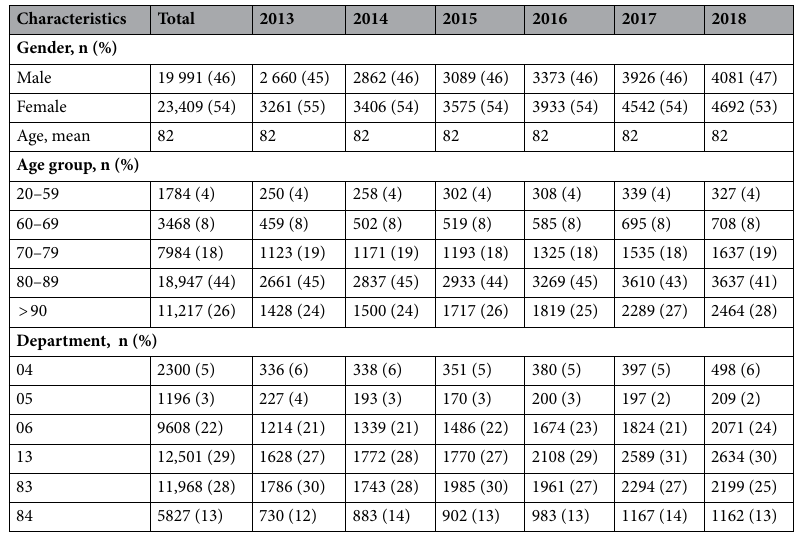
Table 2. Main characteristics of the study population in Région Sud from 2013 to 2018.